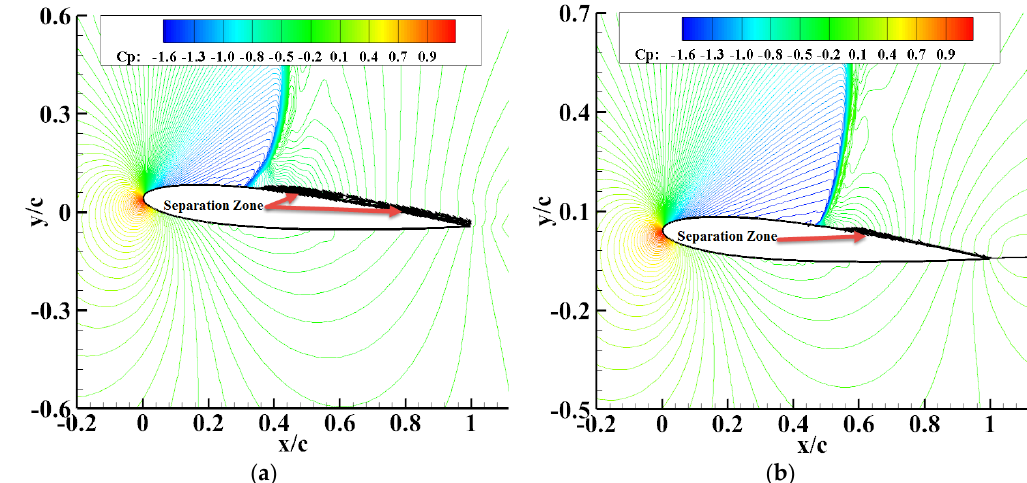
Figure 9. Streamlines at a 5.0° incidence angle ( a ) without tangential blowing and ( b ) with tangential slot blowing.